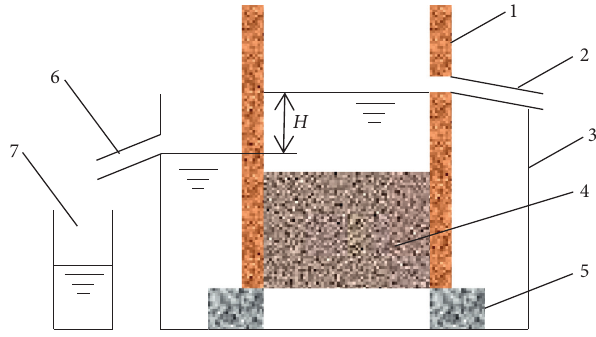
Figure 4: Schematic diagram of the permeable test device. ∗ Notes: 1: steel mold; 2: vent pipe; 3: water tank; 4: concrete specimen; 5: pad; 6: outlet pipe; 7: measuring